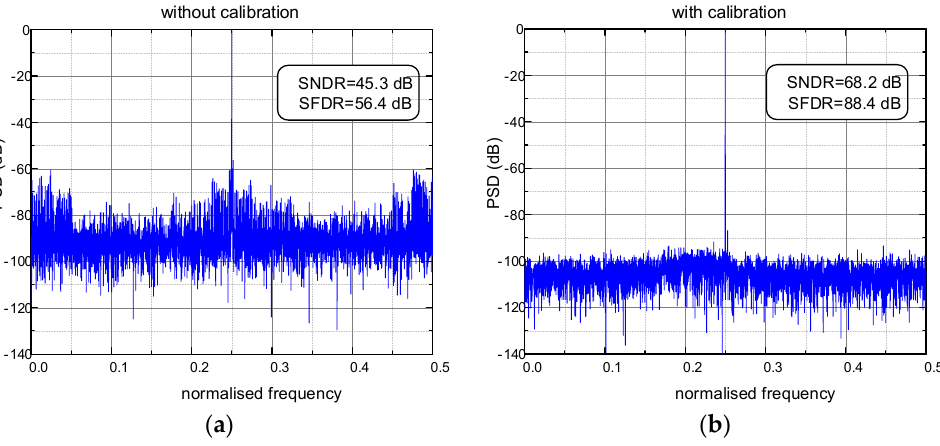
Figure 4. Output spectra: ( a ) without calibration; ( b ) with calibration.